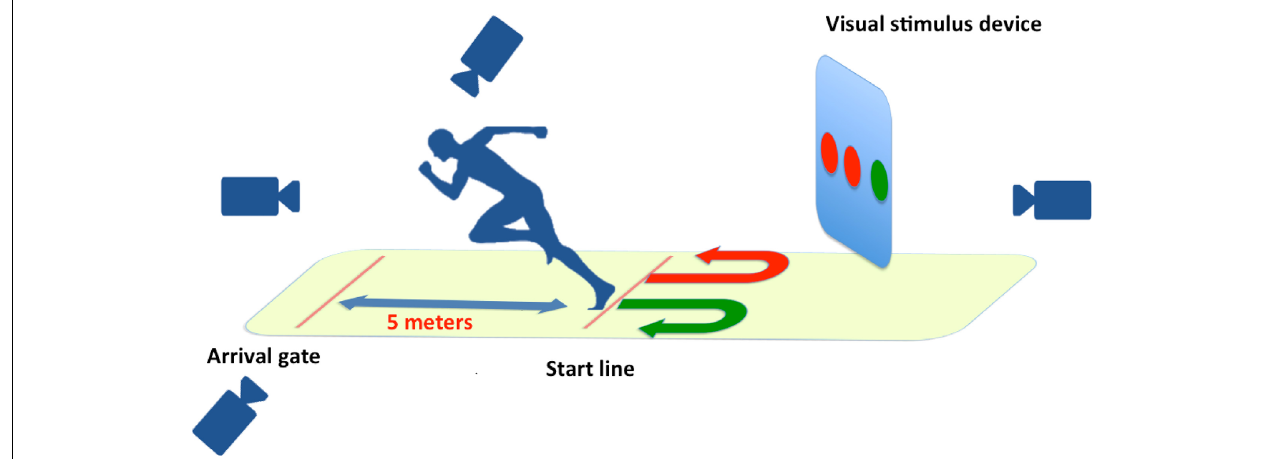
FIGURE 1 | Equipment set up for the agility test. The device showed the side of the rotation: when the left light turned red, the player performed a left rotation and conversely when the right light turned red, the player performed a right rotation. When the center light turned red, the player chose the preferable side to turn. The device was seated on a tripod with adjustable height, therefore each test was arranged at the player’s eye level. To achieve the agility test, the player had to execute a 180 ◦ turn and run as fast as possible to the arrival gate placed 5 m behind